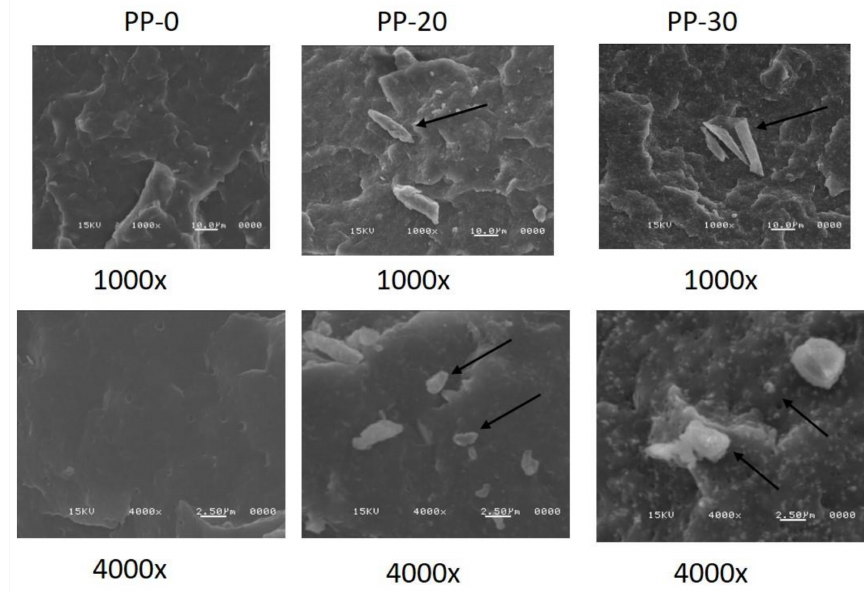
Figure 5. Scanning electron micrographs of PP-0, PP-20, and PP-30 at 1000 × and 4000 ×